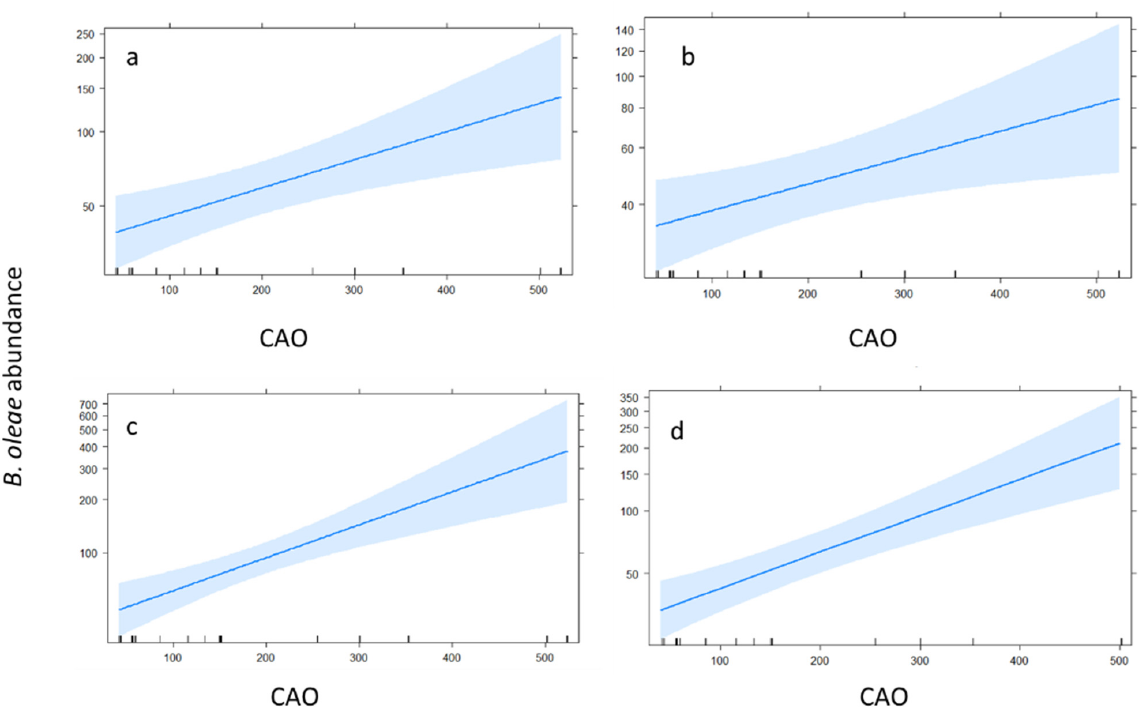
Figure 5. Effect of landscape structure on Bactrocera oleae abundance in spring 2015 ( a ), autumn 2015 ( b ), spring 2016 ( c ) and autumn 2016 ( d ). Landscape Index was olive grove area (CAO) calculated at 1500 m buffer areas.